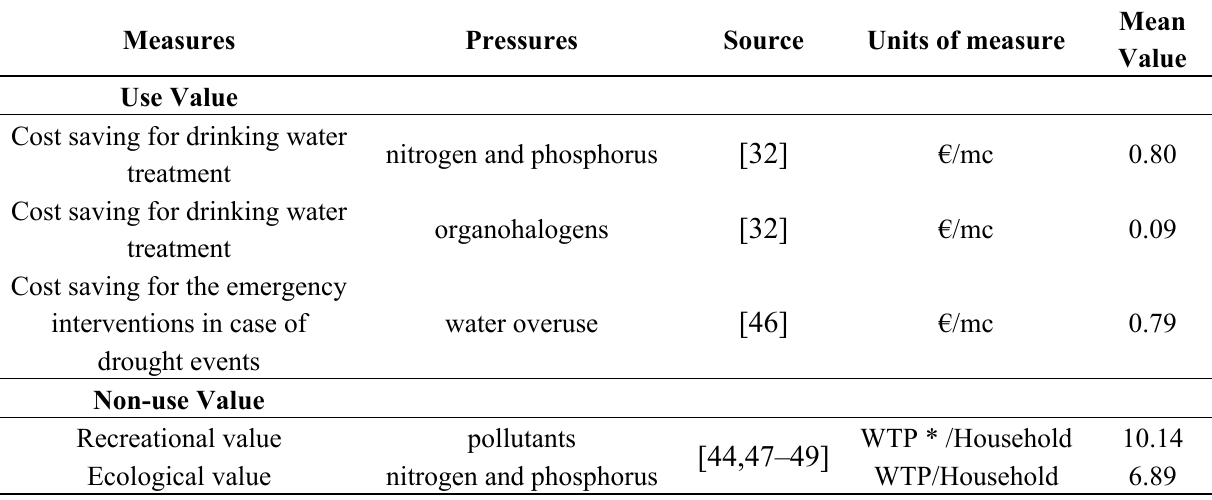
Table 3. Average unit benefit estimates for good water